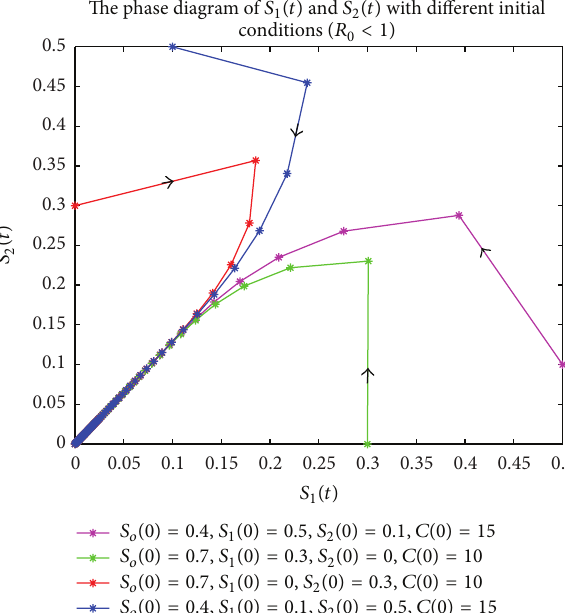
Figure 2: The phase diagram of 𝑆 1 (𝑡) and 𝑆 2 (𝑡) with 𝑘 1 = 4 and = 5 . This gives 𝑅 ≈ 0.8858 < 1 and the coopetition makes the 𝑘 2 0 market share of the enterprise not coexist.